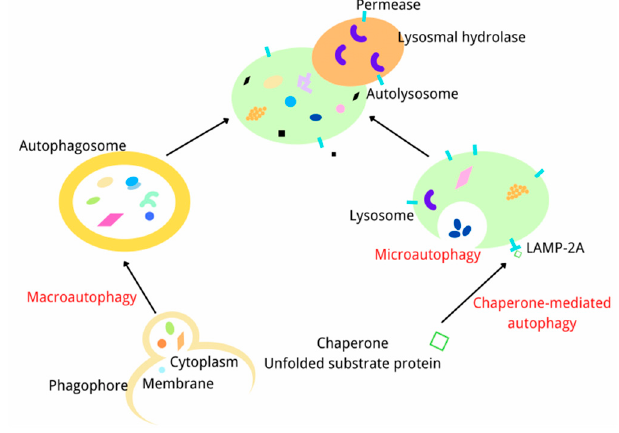
Figure 2. The Diagram of the process of three kinds of autophagy.